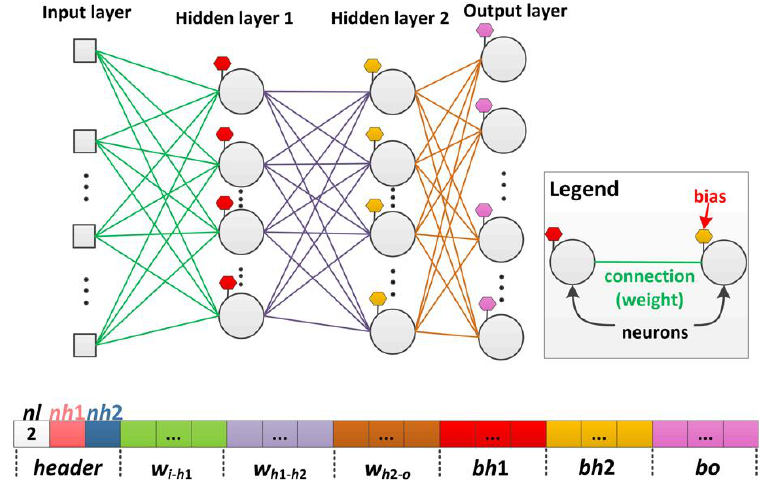
Figure 2. A general structure of an MLP and its associated coded solution.